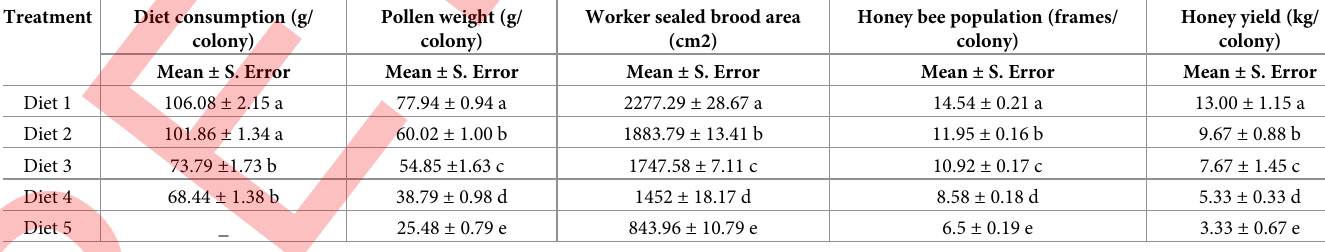
_ 25.48 ± 0.79 e 3.33 ± 0.67 e The different small letter within each column represents statistically significant differences (p <